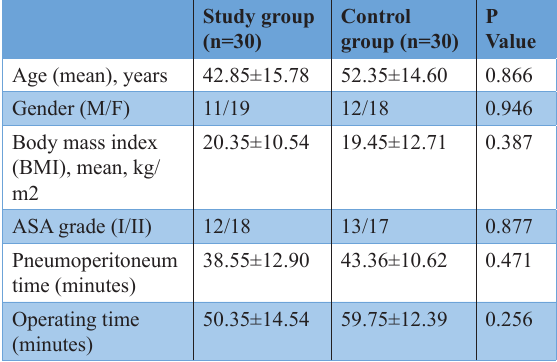
Table1. Baseline Characteristics-Comparisons between the two groups